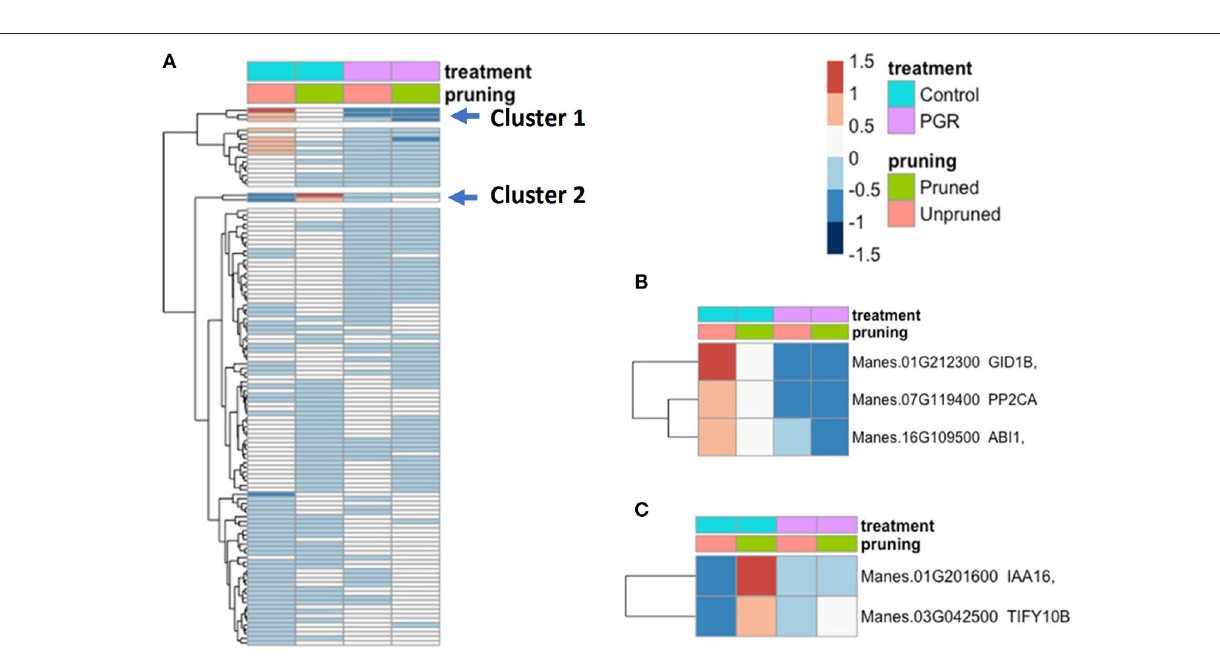
FIGURE 9 | (A) Differentially expressed hormone-signaling genes in response to PGR and pruning. Clusters of highly affected genes are indicated with arrows. Clusters 1 and 2 are shown in detail in (B,C) , respectively. Averages of five biological replicates. Color scale indicates log 2 fold changes. Legend in header indicates color coding of variables. PGR, plant growth